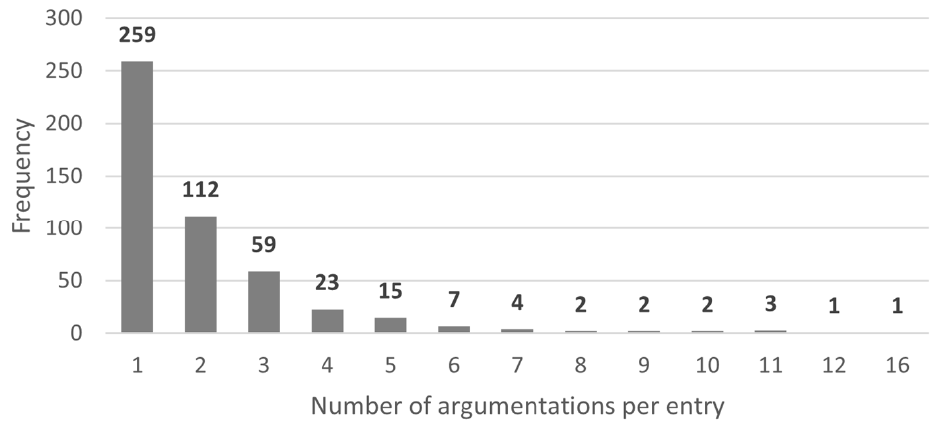
Figure 2. Distribution of the number of arguments per entry in normative works on Standard Dutch from ca. 1550 to 1650 (total number of ARGUMENTATION entries: n = 490).